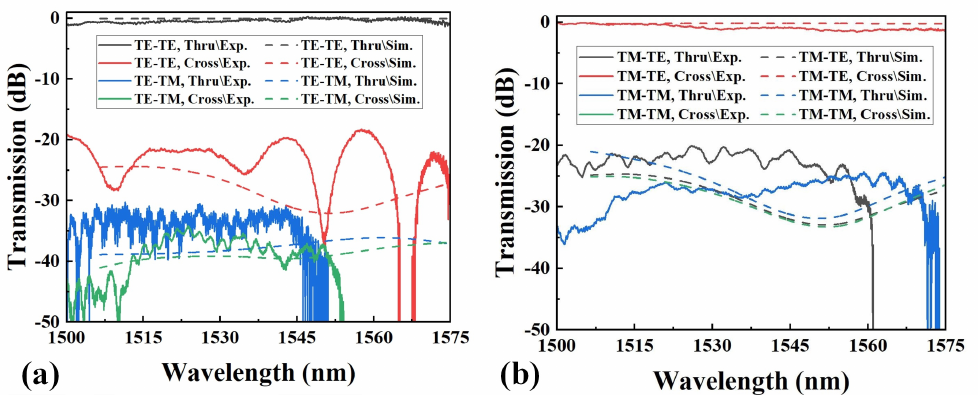
Figure 5. Measured transmission spectra for the ( a ) TE 0 and ( b ) TM 0